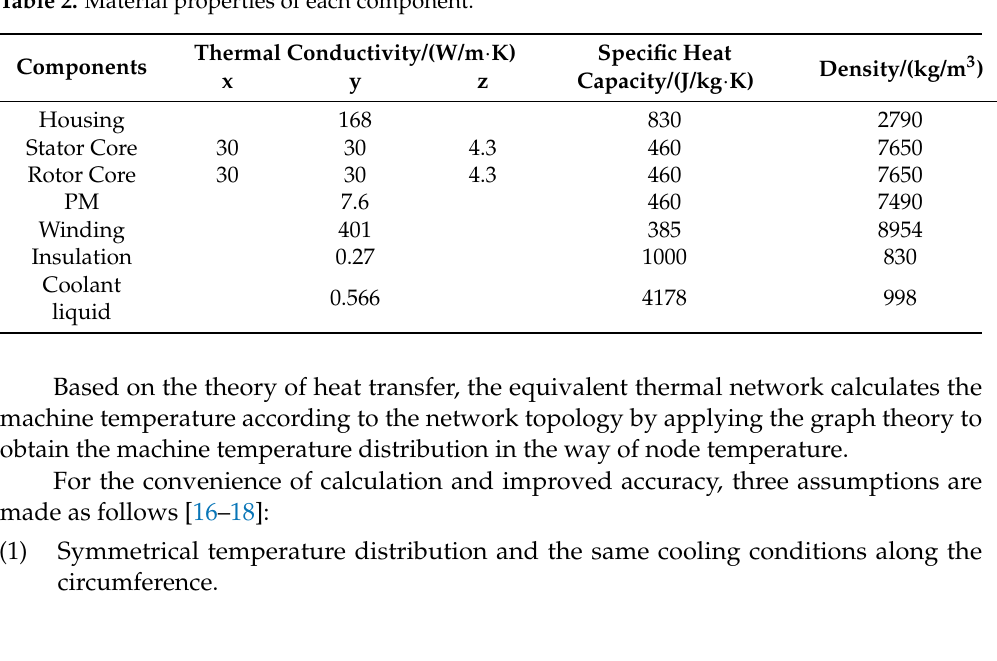
Table 2. Material properties of each